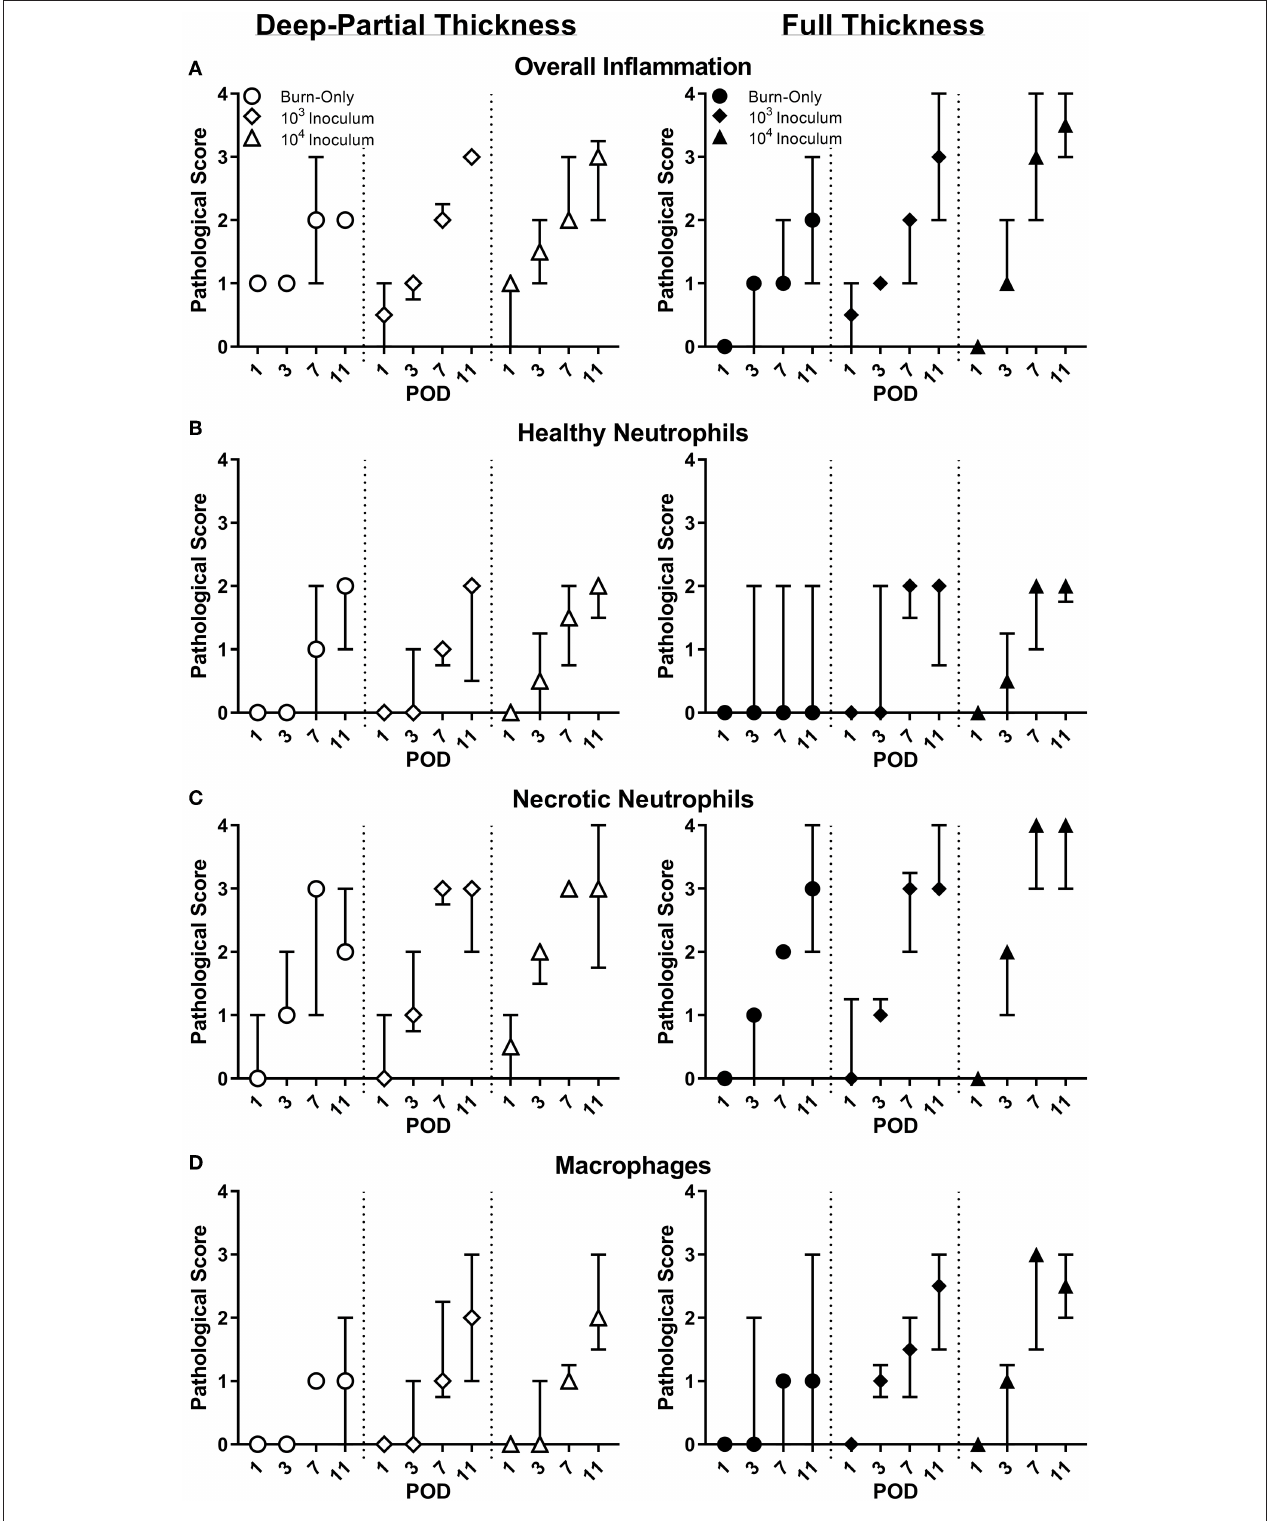
FIGURE 1 | Pathological assessment of DPT & FT burn wounds. Overall inflammation (A) was elevated from the burn wound injury; however, infected wounds saw a greater inflammation by POD 11. Compared to DPT injuries, P. aeruginosa also triggered faster and/or greater influx of neutrophils (B,C) and macrophages (D) into FT burn wounds following a 10 4 CFU/wound